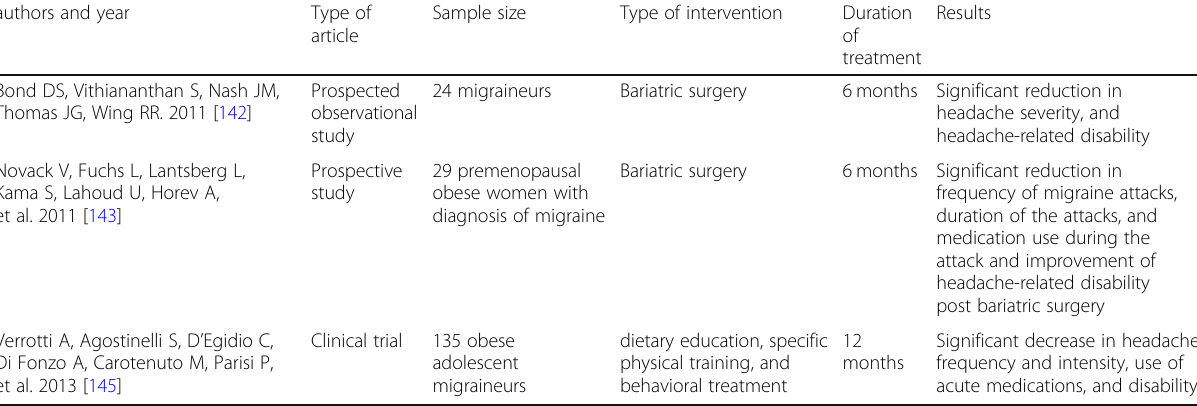
Table 3 Literatures on effects of weight loss on migraine headache authors and